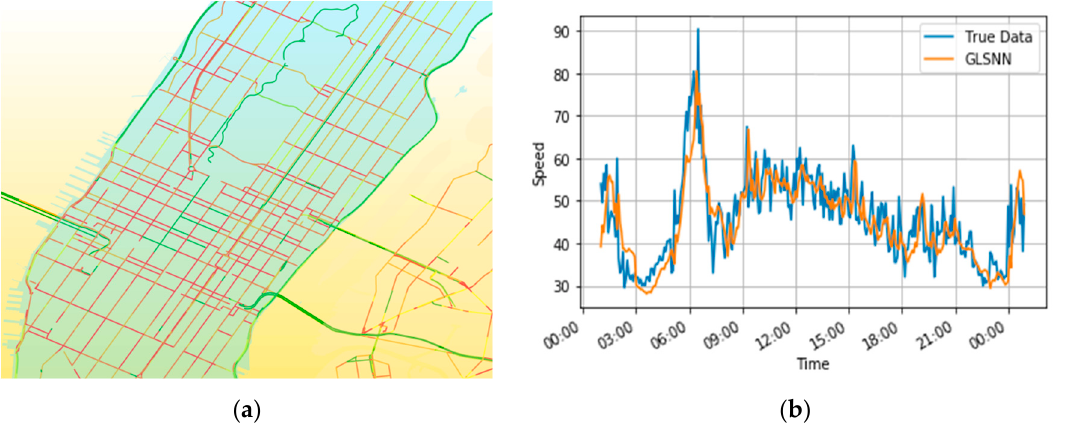
Figure 7. Visualization of traffic flow prediction results for city arteries: ( a ) the popular area of New York City; ( b ) the prediction results compared with real data.